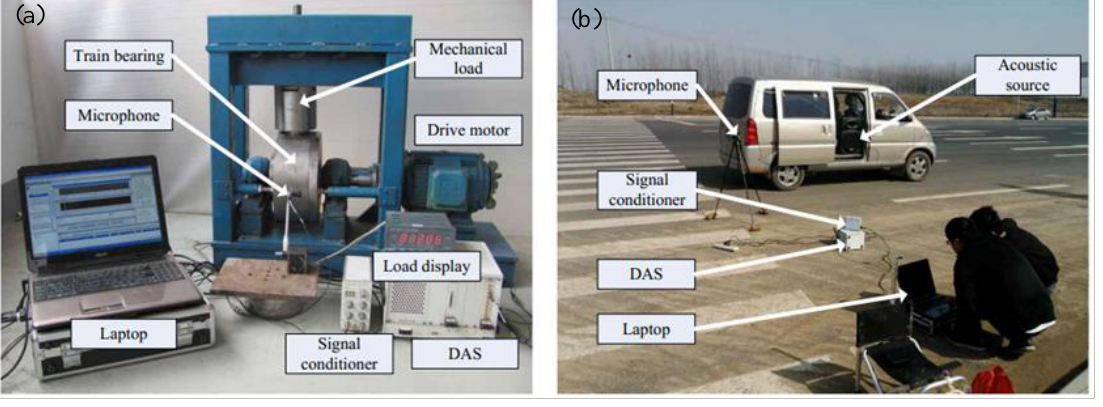
Figure 15. Experimental setup for signal acquisition with Doppler effect ( a ) test bench of the first experiment and ( b ) scene of the second experiment. (a)